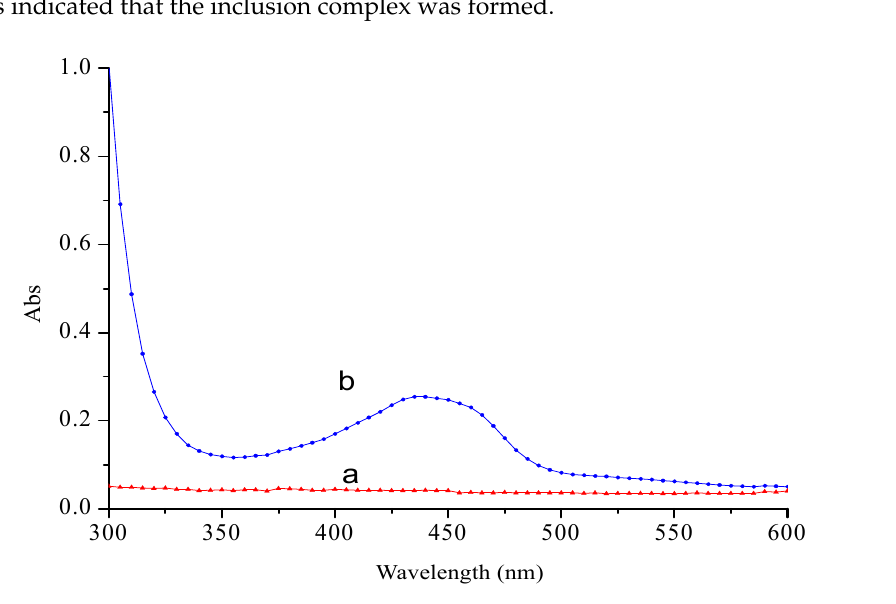
Figure 4. UV spectra of cyclodextrin polymer ( a ) and curcumin/cyclodextrin polymer inclusion complexes ( b ) at a wavelength of 300–600 nm at room temperature.